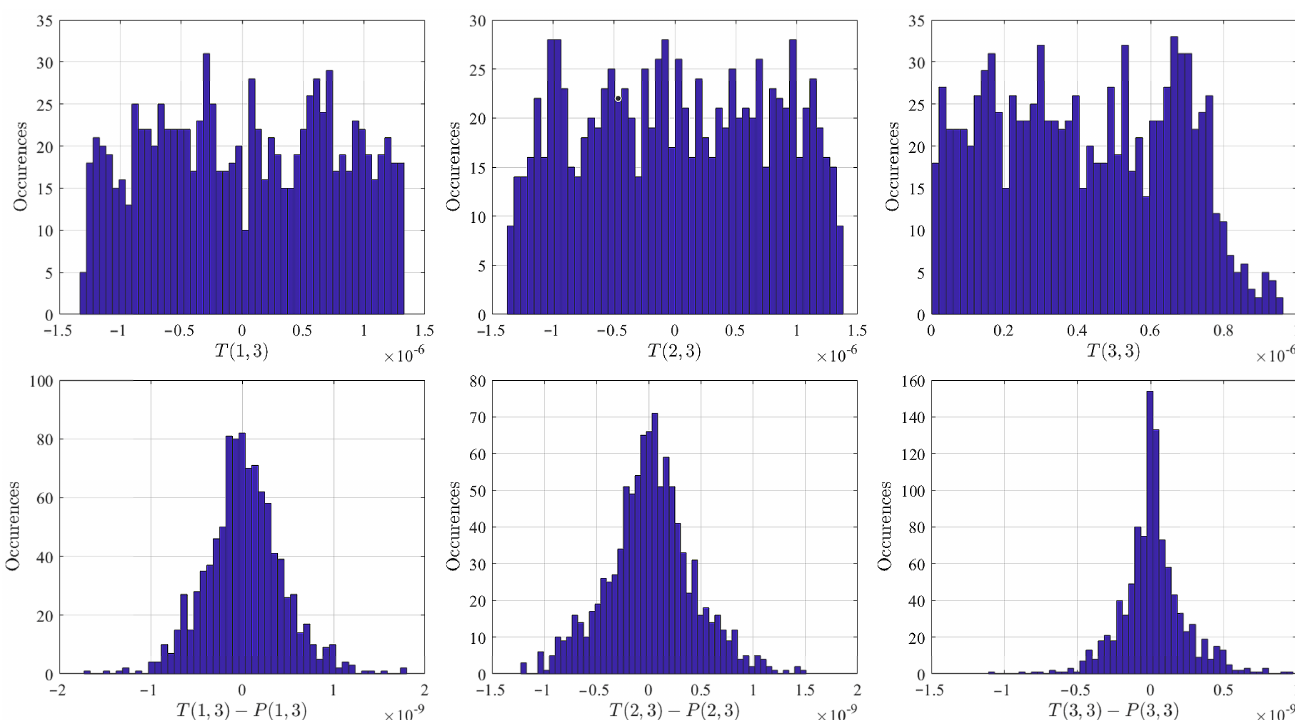
Figure 4. Monte Carlo validation for the P ( 1,3 ) , P ( 2,3 ) and P ( 3,3 )